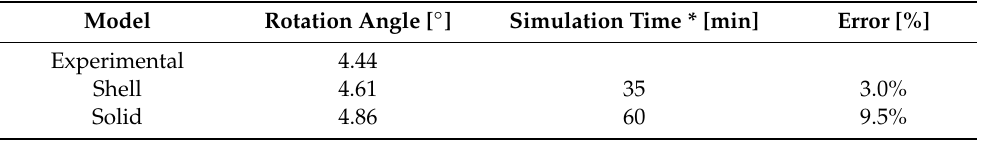
Table 3. Comparison of the maximum deflection of the ski in the torsion-bending test: FEM vs. experiments.